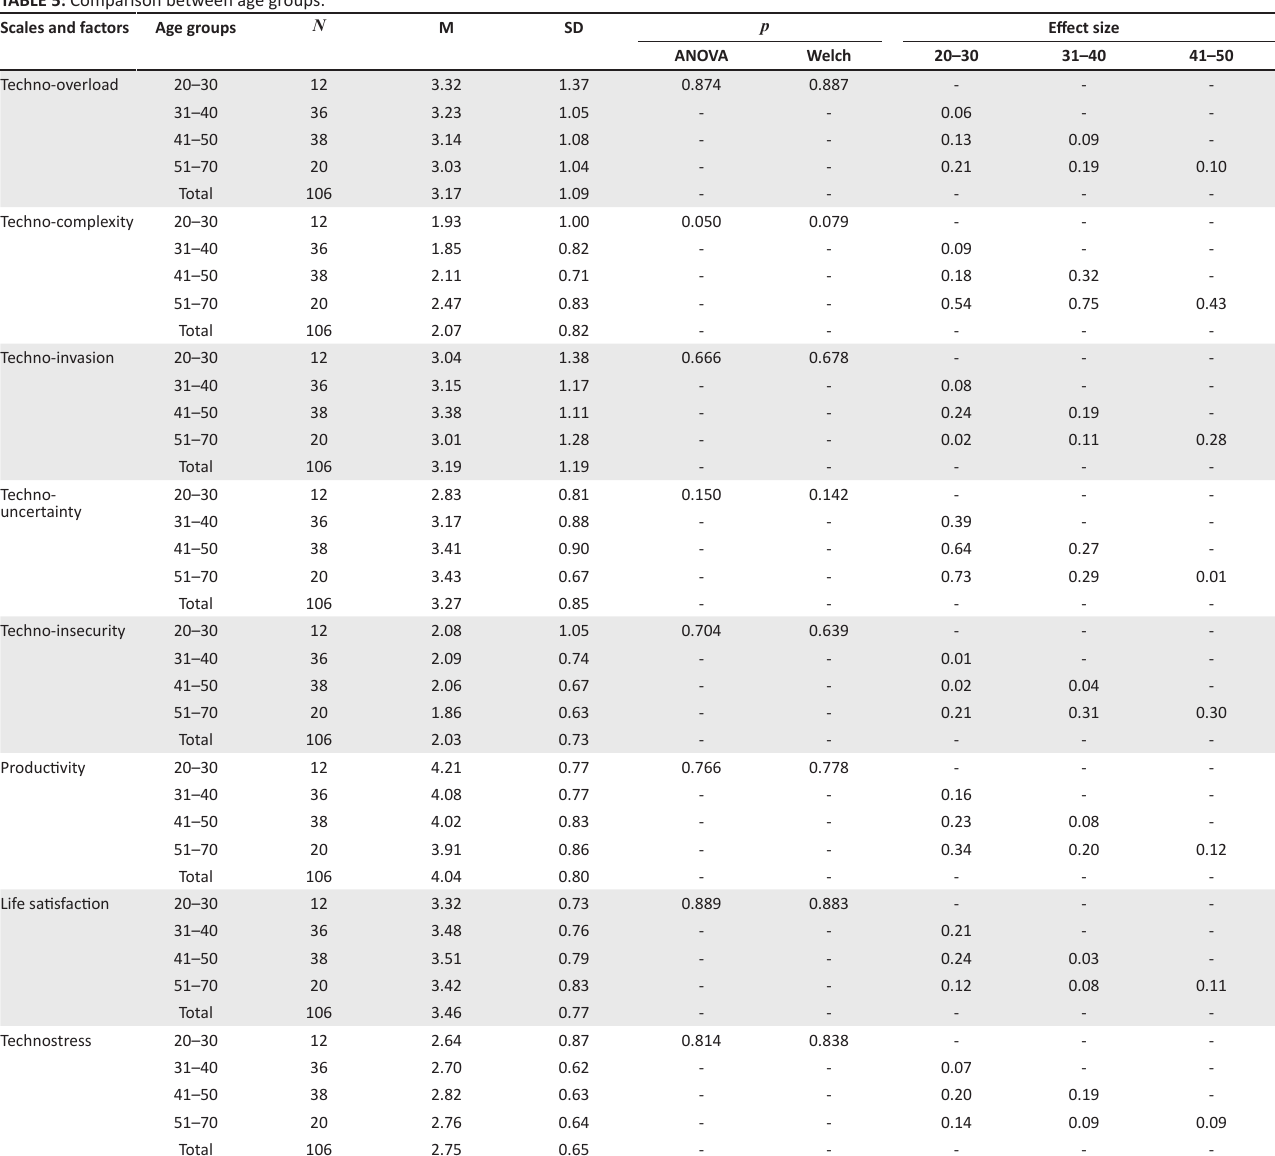
TABLE 5: Comparison between age groups. Scales and